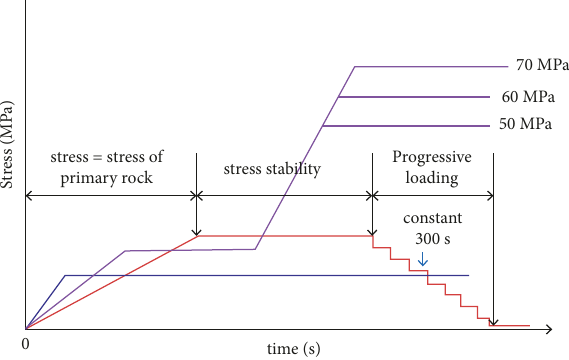
Figure 2. The true triaxial rock press machine and CT